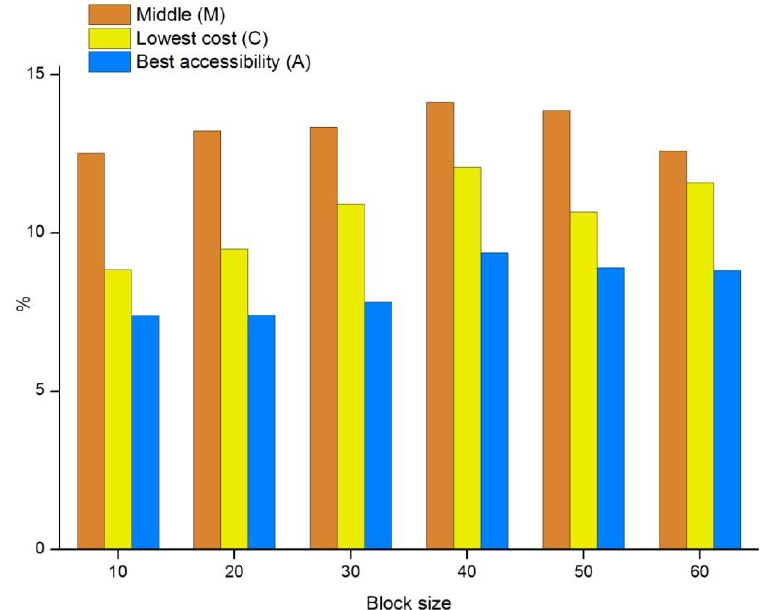
Figure 3. The error in paths calculated with the HPA* method using three different transition placement options and six different block sizes, compared to true optimum paths calculated with the conventional nonhierarchical